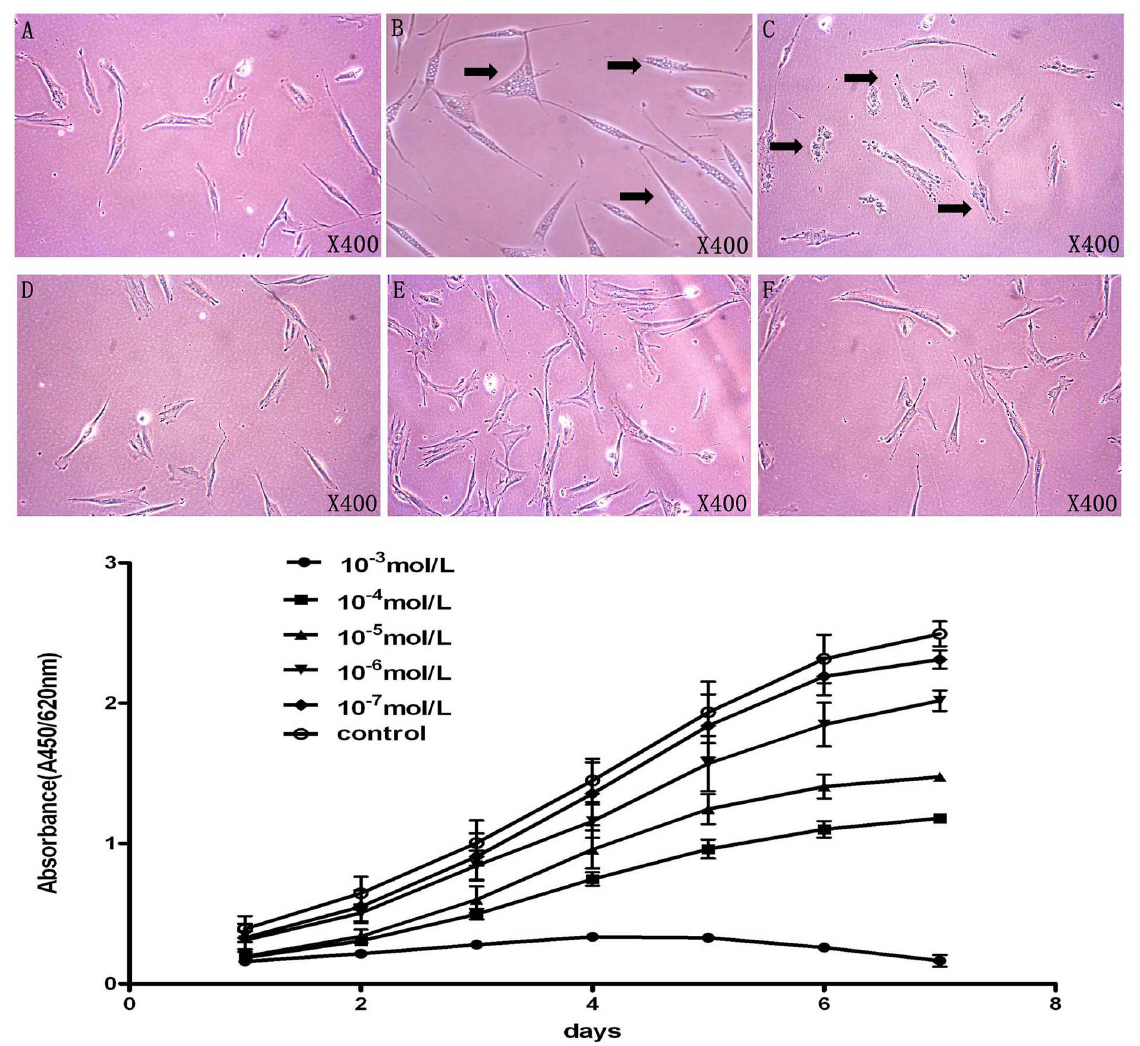
Figure 2. Nicotine affects the morphology and suppresses the proliferation of hPDLSCs. A : Morphology of PDLSC in control group; B : morphology of hPDLSC with stimulation of nicotine in 10 2 3 mol/L, black arrow indicated the vacuolar degeneration of PDLSCs; C–F : Morphologies of hPDLSC with stimulation of nicotine from 10 2 4 –10 2 7 mol/L, increased granular substance in PDLSCs was indicated by black arrow; G : Proliferation of hPDLSCs from each group was determined by WST-1 assay. Nicotine with different concentrations suppresses the proliferation of hPDLSC.